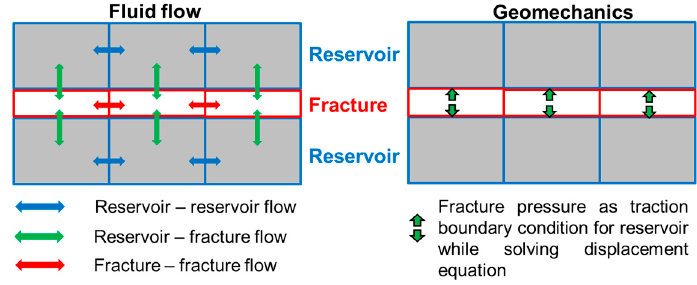
Figure 1. Fluid flow and geomechanics coupling between reservoir and fracture